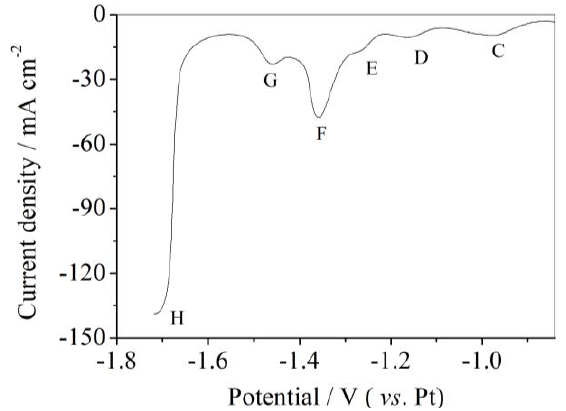
Figure 3. Square wave voltammogram of a Ni wire electrode in LiCl-KCl-AlCl 3 (2 wt.%) melts plotted from − 0.85 V to − 1.72 V at 753 K.